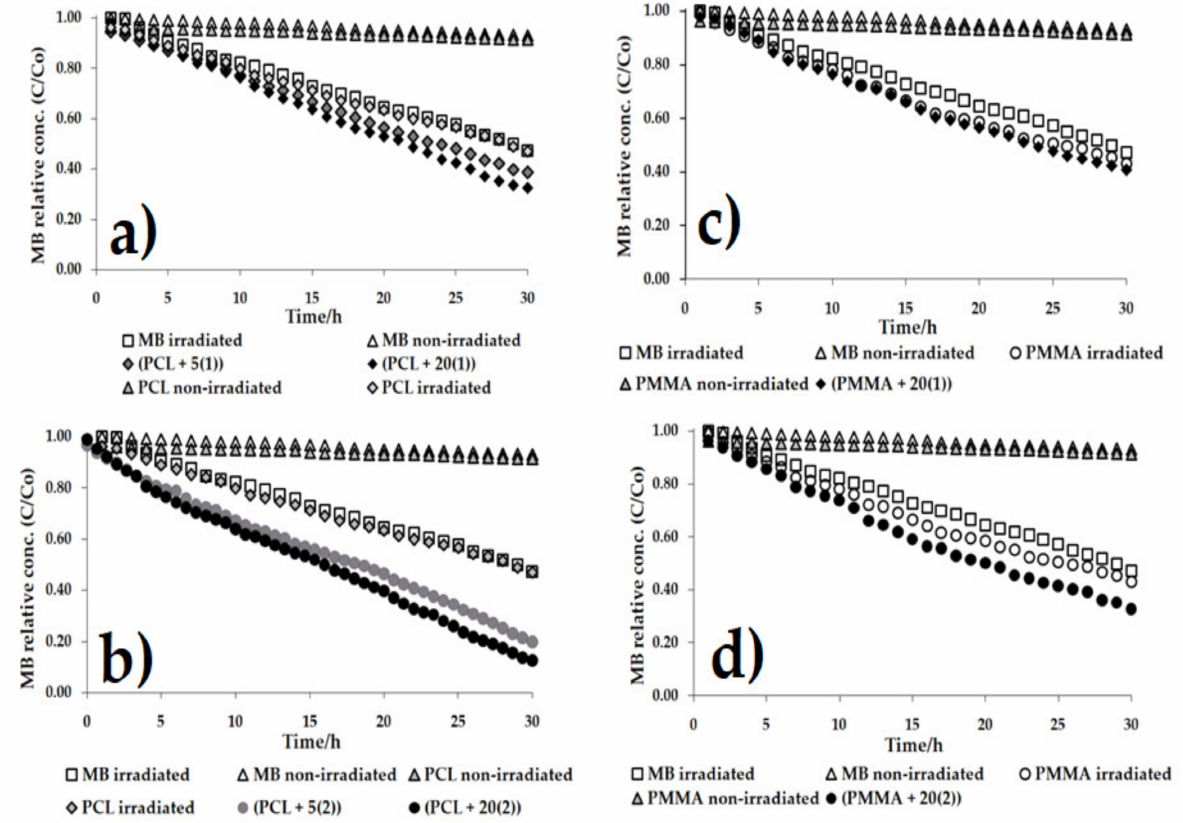
Figure 7. Changes in the concentrations of the methylene blue (MB) solution as a function of time for the respective composite materials irradiated with VIS radiation (( a ) PCl + n ( 1 ), ( b ) PCL + n ( 2 ) ( n = 5, 20 wt.%), ( c ) PMMA + 20( 1 ), ( d ) PMMA + 20( 2 ) ( n = 20